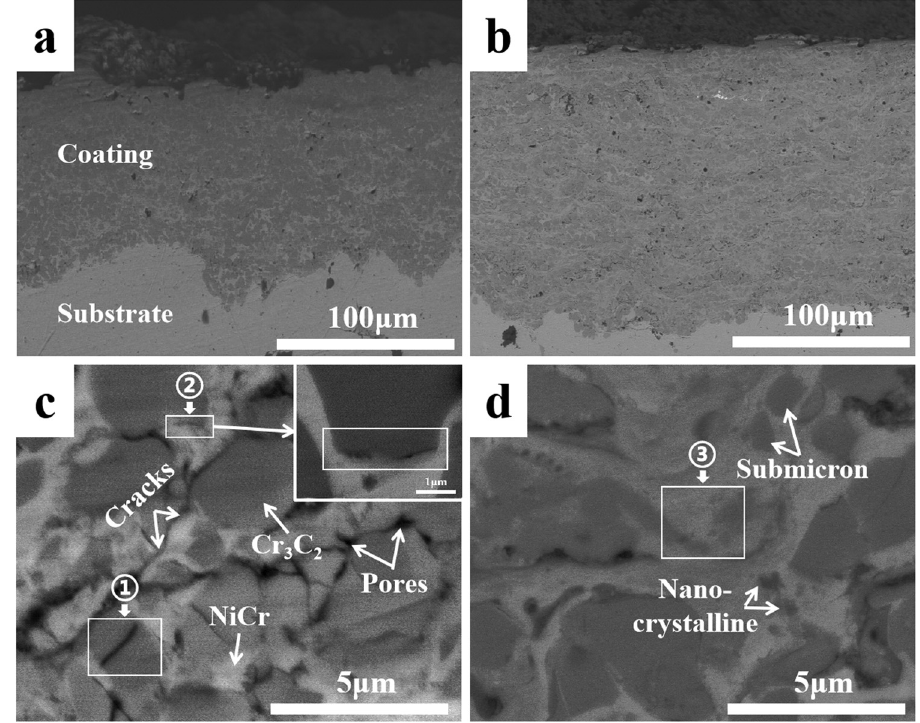
Figure 5: Cross - sectional SEM images of Cr 3 C 2 – NiCr coatings: ( a and c ) CC and ( b and d )